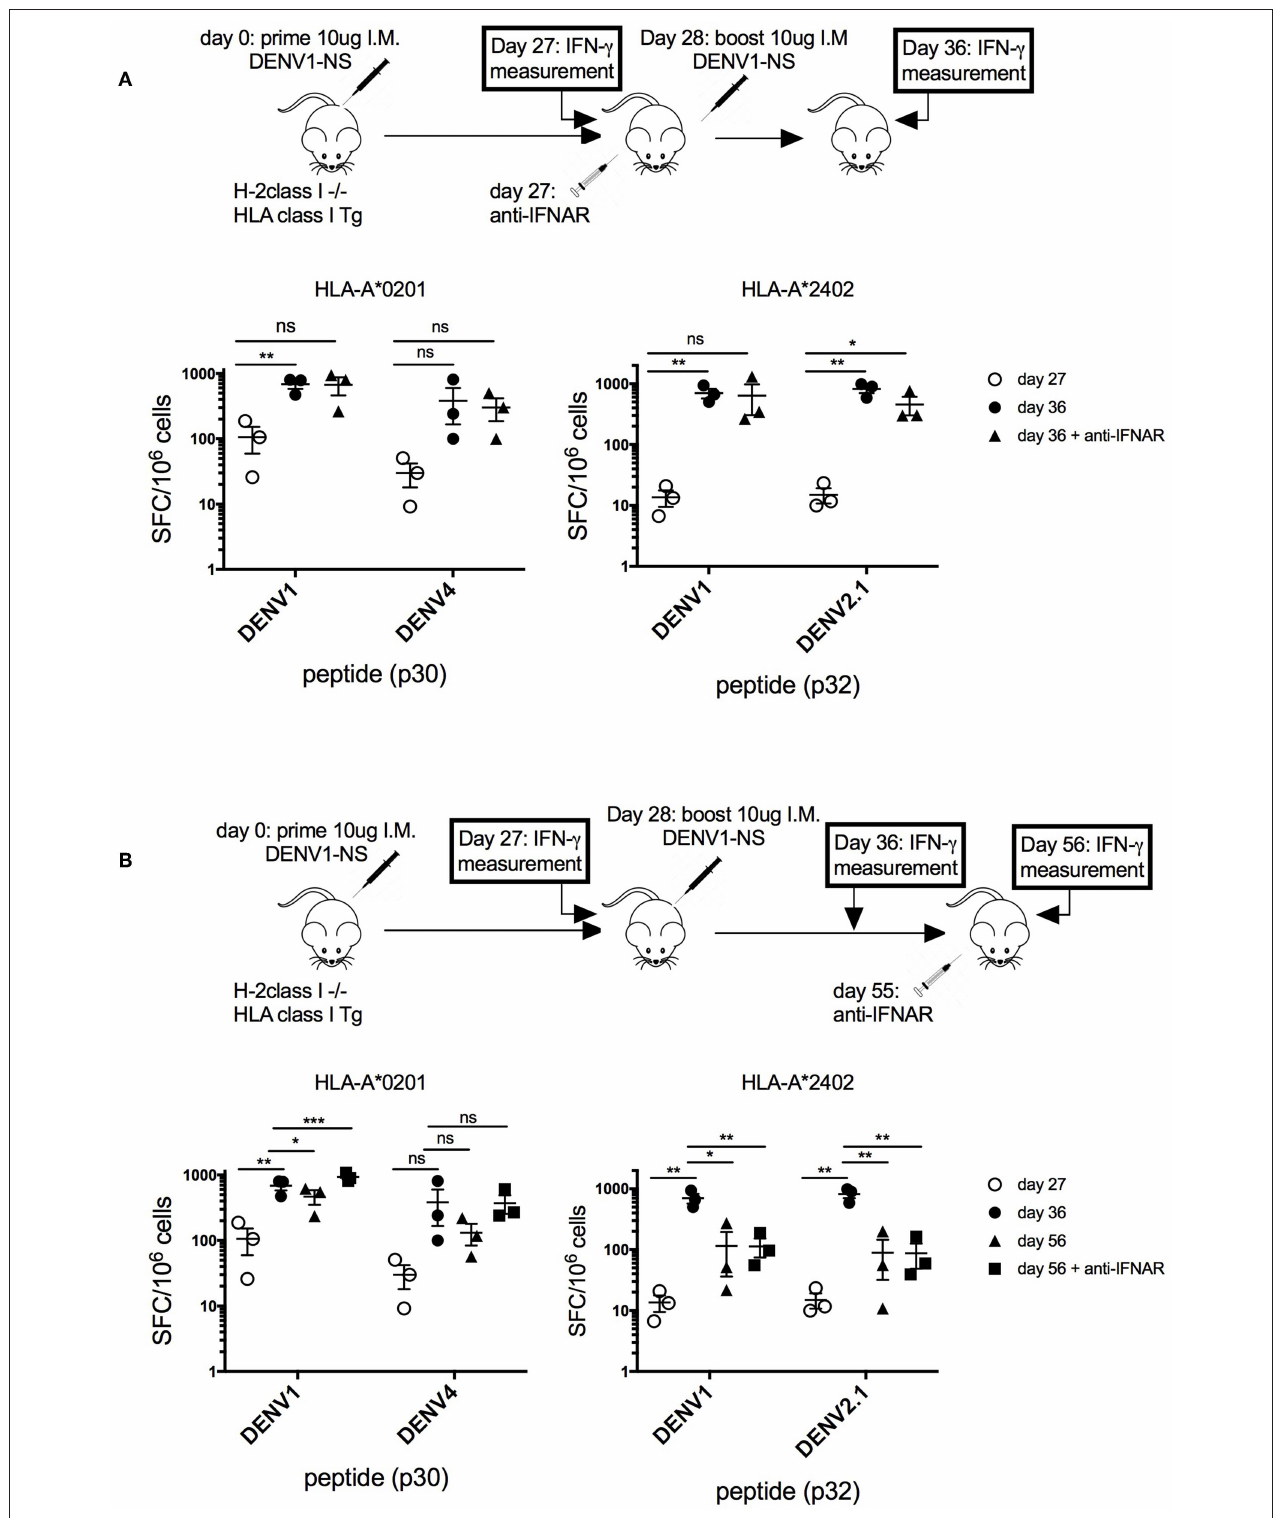
FIGURE 4 | Effect of transient blockade of type I IFN signals on the expansion and contraction phases of antigen-specific T cells. (A) Three groups of 3 HLA-A*02:01 transgenic mice and 3 groups of 3 HLA-A*24:02 transgenic mice received 2 intramuscular inoculations of 10 µ g of the LNP-based mRNA encoding DENV1-NS